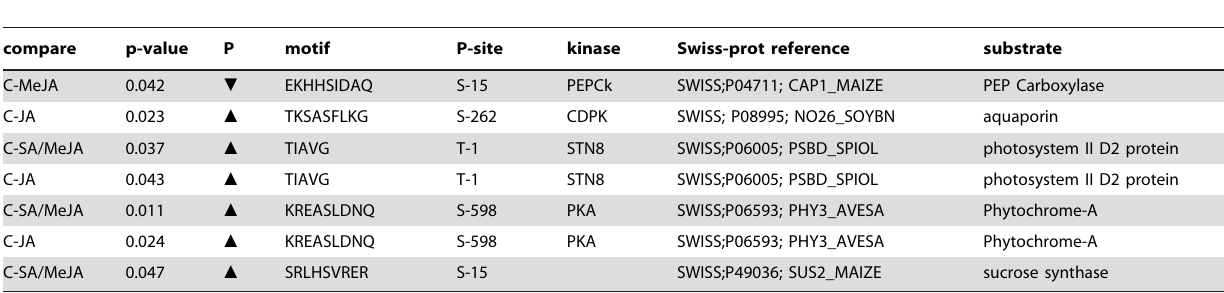
(Table 1). Additionally, peptides of PhyA, PSII D and a Sucrose Synthase showed enhanced phosphorylation after combined SA/ MeJA treatment (Table 1). This indicates that the proteins from which these peptides are derived are post-translational regulated during MeJA and SA/MeJA signaling. Table 1. Plant-specific peptide-substrates differentially phosphorylated after MeJA and SA/MeJA treatment.